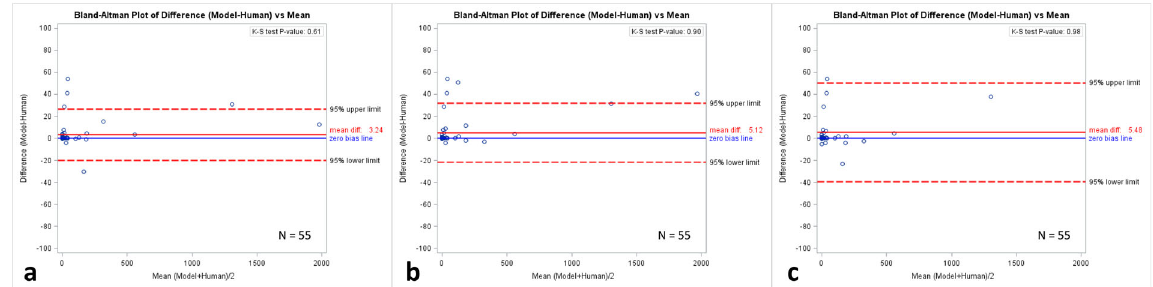
Fig. 3 Comparison of automated scoring using deep learning and manual scoring in a prospective cohort. Bland – Altman plots comparing prospective automated scoring of gated AI model to manual scoring of CAC by three different ( a – c ) technologists using gated coronary CT exams. Please refer to Supplementary Fig. 2 for a zoomed version of the Bland – Altman